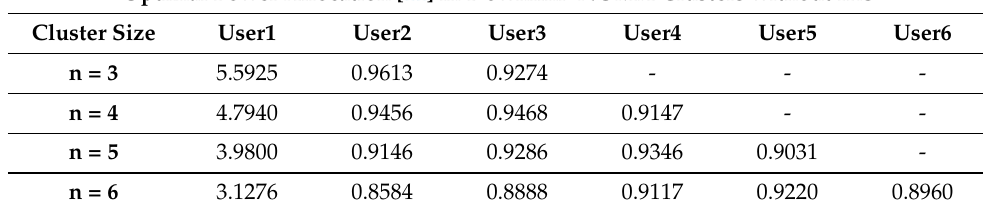
Table 8. Normalized IDR analysis in bits per sec per Hertz of Optimal power allocation [11] in downlink NOMA clusters without IRS.